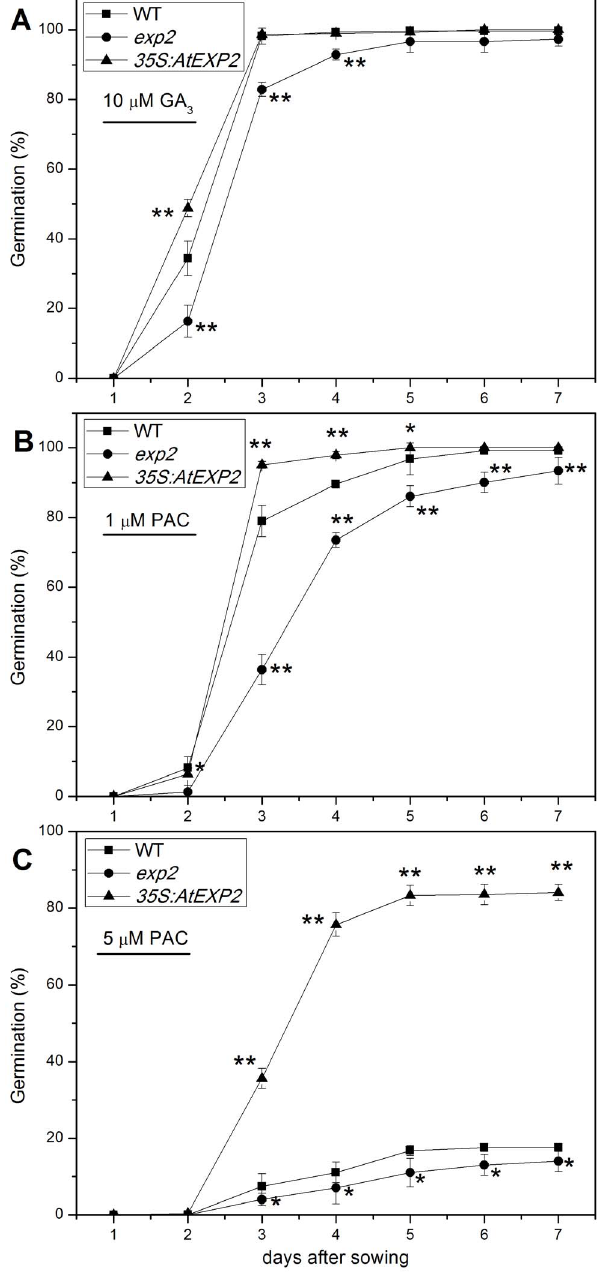
Figure 6. Germination phenotype of the wild type, exp2 and 35S:AtEXP2 line in response to GA and PAC treatment. Seeds of wild type, exp2 and 35S:AtEXP2 line were treated with 10 m M GA 3 (A), 1 m M (B) or 5 m M (C) paclobutrazol (PAC). Error bars represent SD. A Student’s t-test was calculated at the probability of either 5% (*P , 0.05) or 1% (**P ,